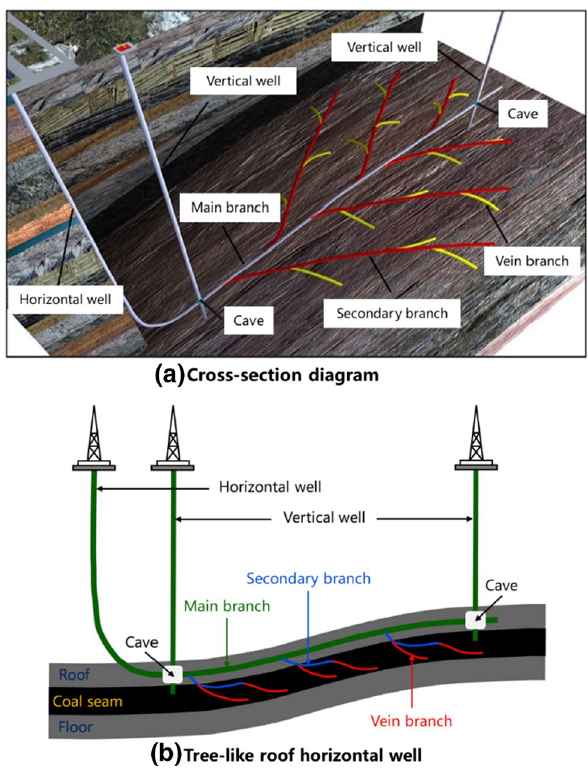
Fig. 14 Schematic of the tree-like horizontal well, modified from Yang et al. (2014) and Tao et al.